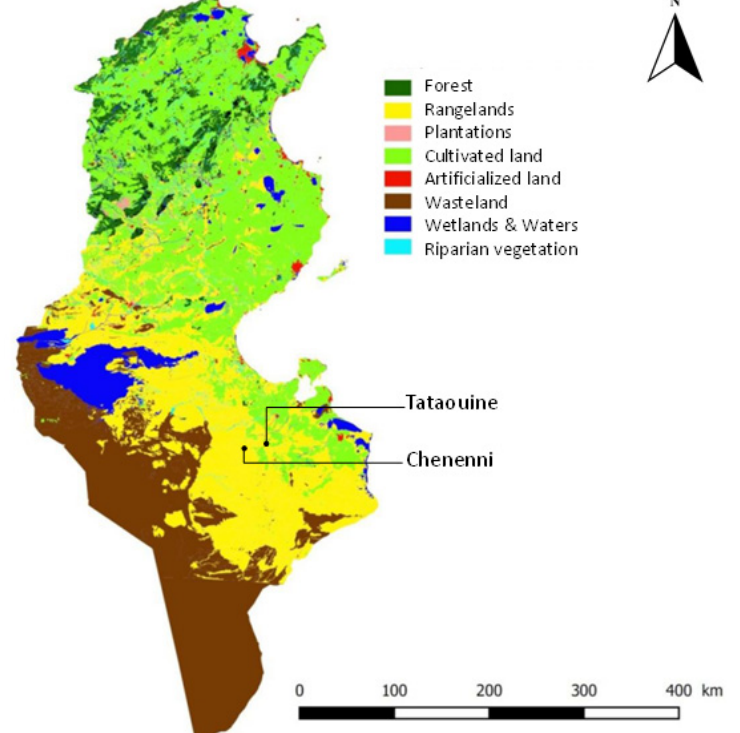
Figure 8. Map of Tunisia (based on land cover type [70]) showing the study site in Chenenni in the Governorate of Tataouine, Southern Tunisia.